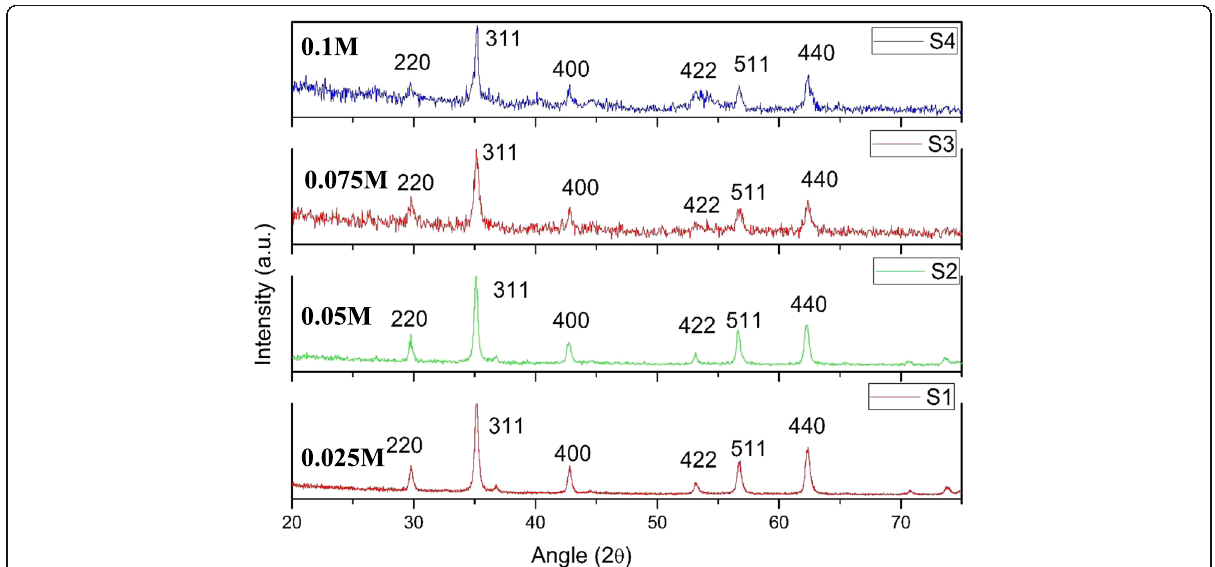
Fig. 1 The XRD profile of Fe 3 O 4 nanoparticles synthesized with different concentrations of FeCl 2